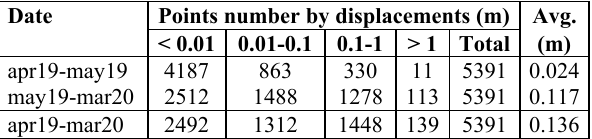
Table 4. Horizontal displacements of gully bank